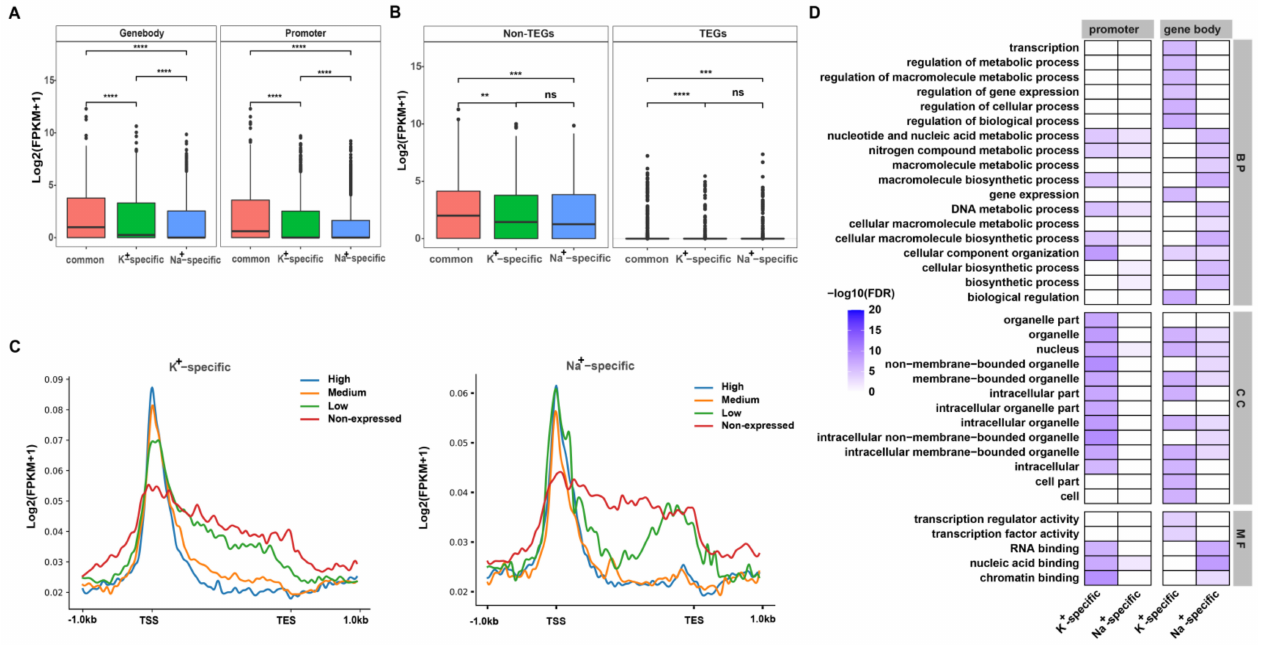
Figure 5. Relationships between each subtype of IP-G4s and transcription of overlapping genes. ( A ) Comparisons of the expression levels of TEGs and non-TEGs overlapping each subtype of IP-G4s. ( B ) Comparisons of the expression levels of genes overlapping each subtype of IP-G4s at promoters and gene bodies. ( C ) Curve plots showing the profile of normalized read counts of K + - and Na + - specific IP-G4s from 1 kb upstream of TSSs to 1 kb downstream of TESs of overlapping genes with different fragments per milobase per million mapped fragments (FPKM) values (high, medium, low, and non-expressed). ( D ) GO terms enrichment assay using K + - and Na + -specific IP-G4 overlapping genes. ** p -value < 0.01, *** p -value < 0.001, **** p -value <